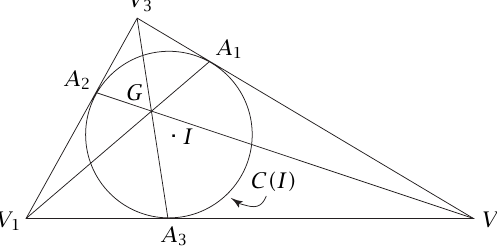
Figure 1 . Incircle C(I) with Gergonne point G in ∆ V 1 V 2 V 3